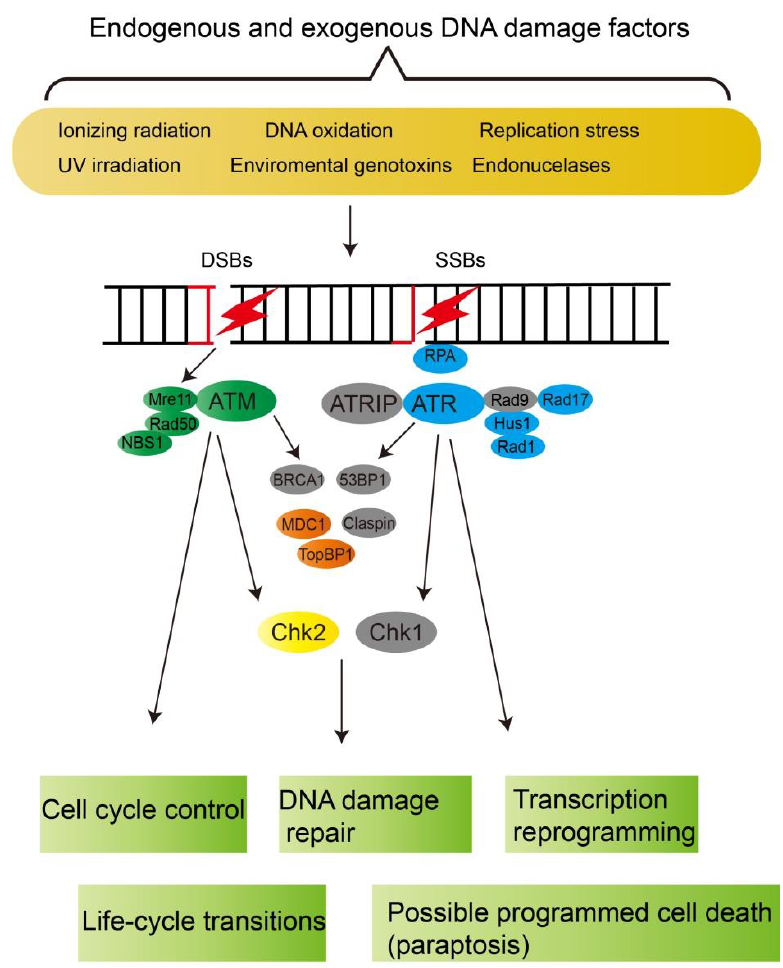
Figure 1. Diagrammatic summary of the DNA damage response signaling network. The grey ellipses denote absence of putative dinoflagellate orthologues, whereas other colors indicate presence of putative dinoflagellate orthologues. For simplicity, nomenclatures differentiating genes, proteins and mutations are not enforced in this study.